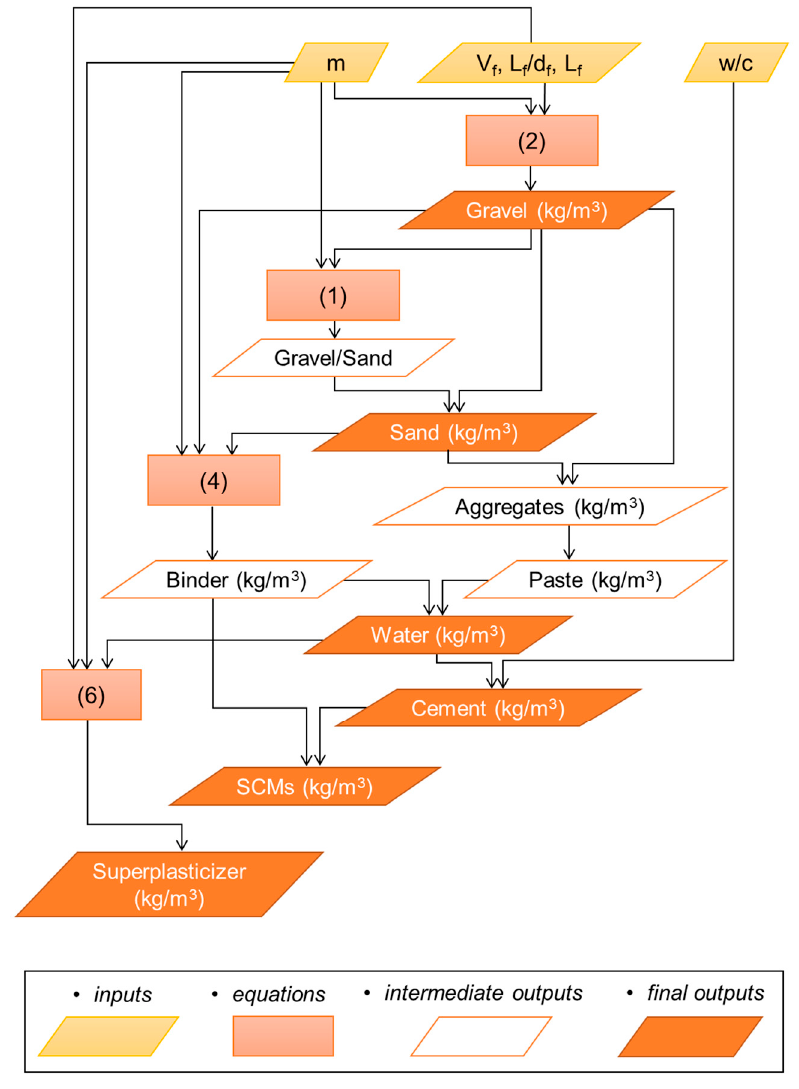
Figure 8. Flow chart of the proposed methodology for SFRC mix design.